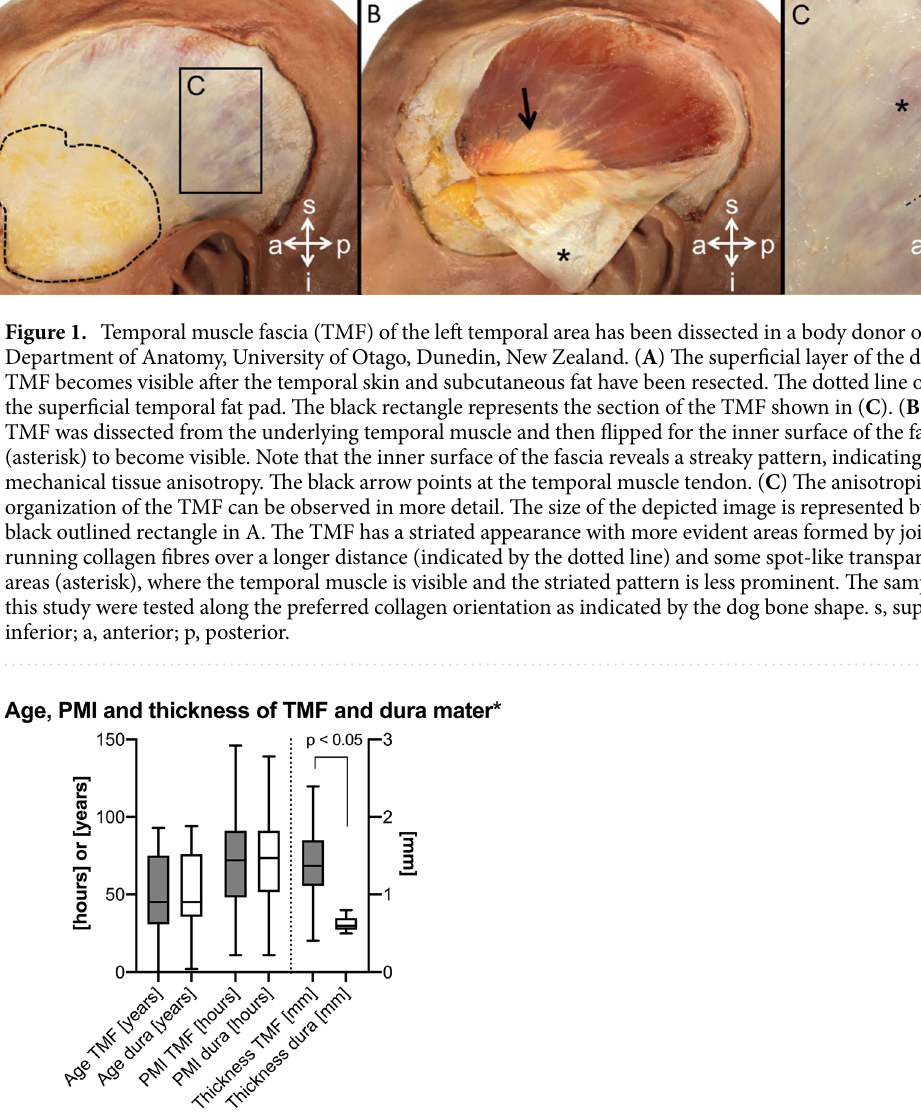
Figure 2. Age, post-mortem interval (PMI) and thickness of the temporal muscle fascia (TMF) samples used for biomechanical testing in this study is displayed (grey boxes). The age, PMI and thickness of recently tested dura mater samples is displayed for comparison (white boxes). The outlines of the boxes indicate the 25% and 75% percentile, the solid black line within the boxes represents the median. Whiskers indicate the minimum and maximum. *Samples tested in a different study 21